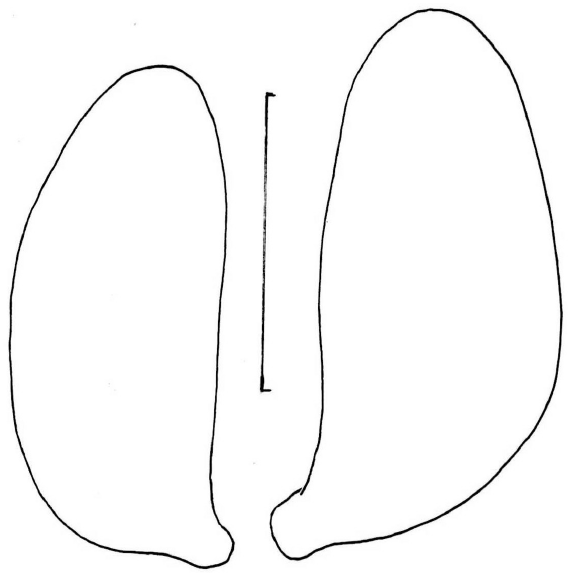
Figure 83. Mycetinis scorodonius f. diminutivus . Basidiospores. Standard bar = 5 µm. WTU 19061-10-